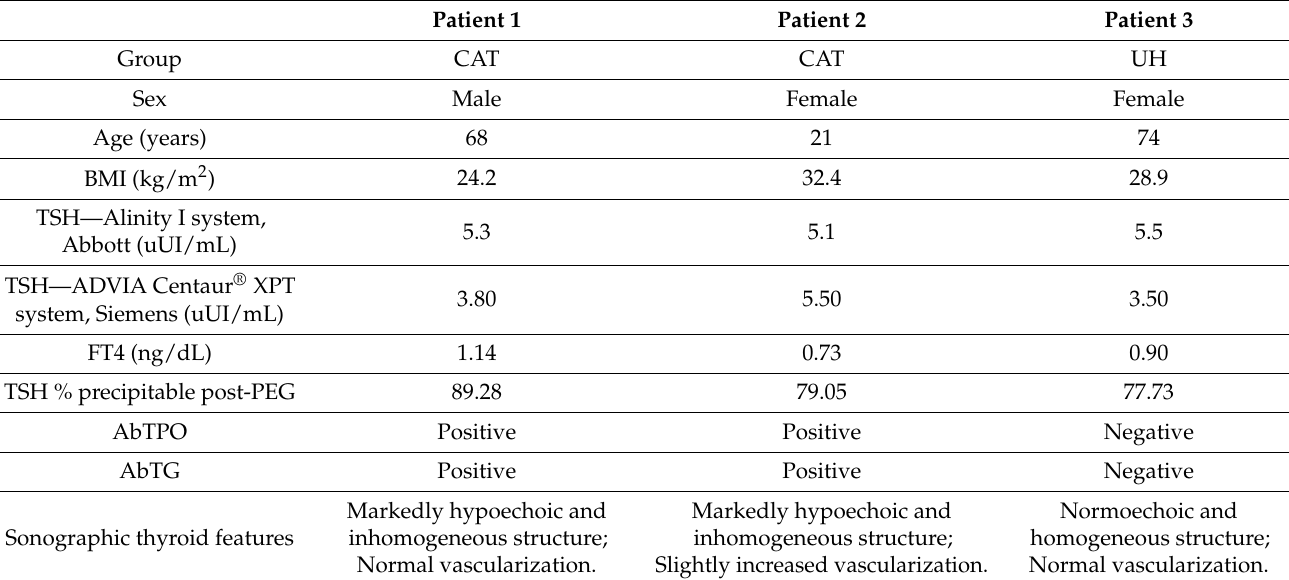
Table 2. Clinical and biochemical characteristics of patients with a PEG-precipitable TSH ratio >